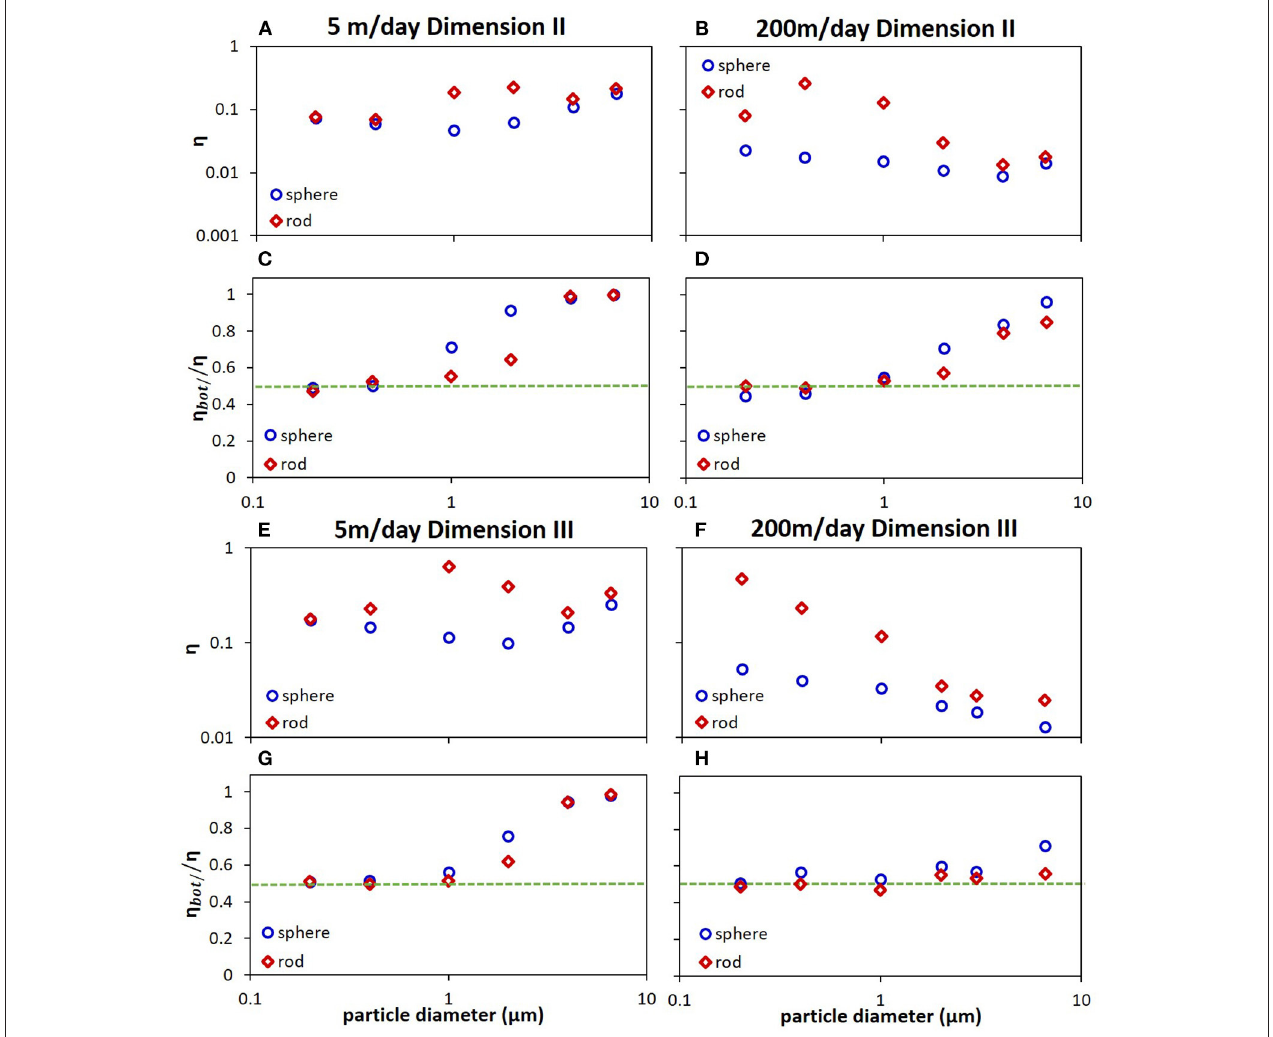
FIGURE 4 | Simulated collector efficiencies (A,B,E,F) and the ratios of particles attached on the bottom plate to the total attachment (C,D,G,H) as a function of particle size for polystyrene spheres (blue circles) and rods (dark red diamonds) from parallel plate model of Dimension II (A–D) and Dimension III (E–H) , under pore water velocity of 5 m/day (A,C,E,G) and 200 m/day (B,D,F,H) . The green dotted line illustrated where attachment on the top plate equaled to that on the bottom plate (i.e., η bot /η = 0.5). Flow direction was perpendicular to the direction of gravity. The statistical error was about 5–10%. Other simulation conditions were given in Table 1